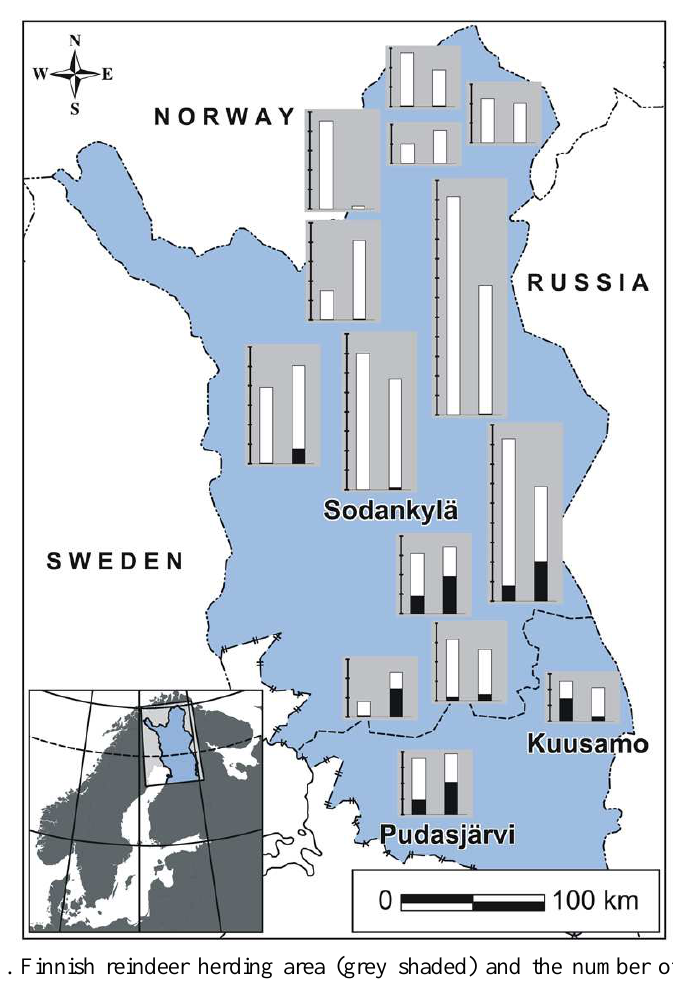
Fig. 1. Finnish reindeer herding area (grey shaded) and the number of reindeer slaughtered (tickmarks indicate 1000s) in different slaughterhouses in years 2003 (left) and 2004 (right). Visceral organs condemned (black). The province of Oulu below and province of Lapland above the dash line (---). The slaughterhouse of Rovaniemi, and two small slaughterhouses omitted because of not defined (not local) area of reindeer